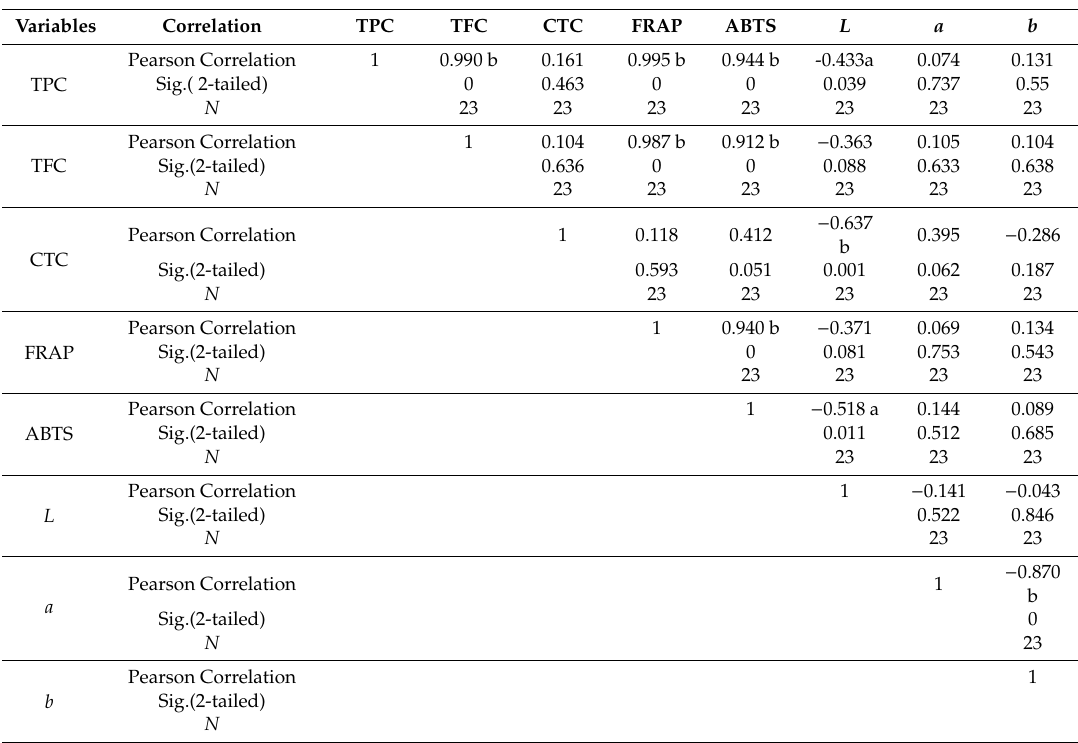
Table 3. Correlation between phenolics (TPC, TFC, CTC), antioxidant capacity (FRAP, ABTS), and color values by 23